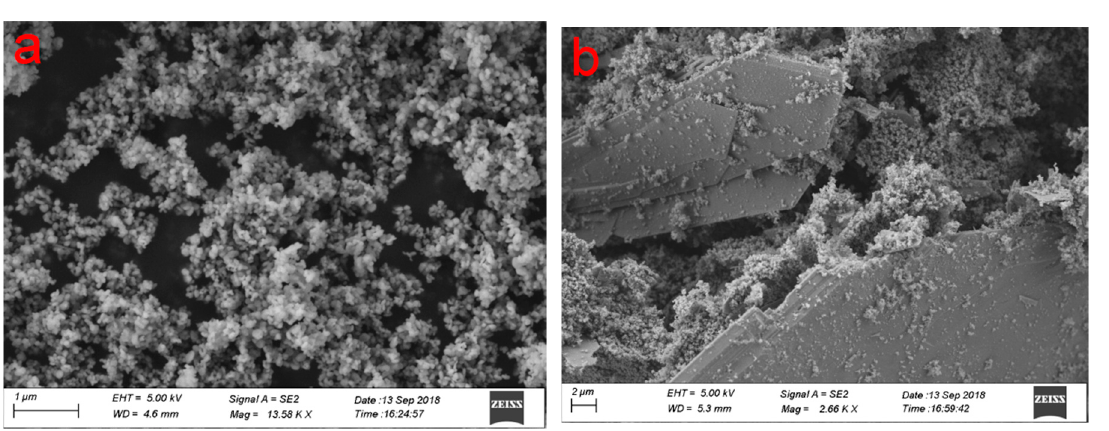
/ Bi ff erent ZnO contents. 2 S 3 , and ZnO 2 S 3 composites with di